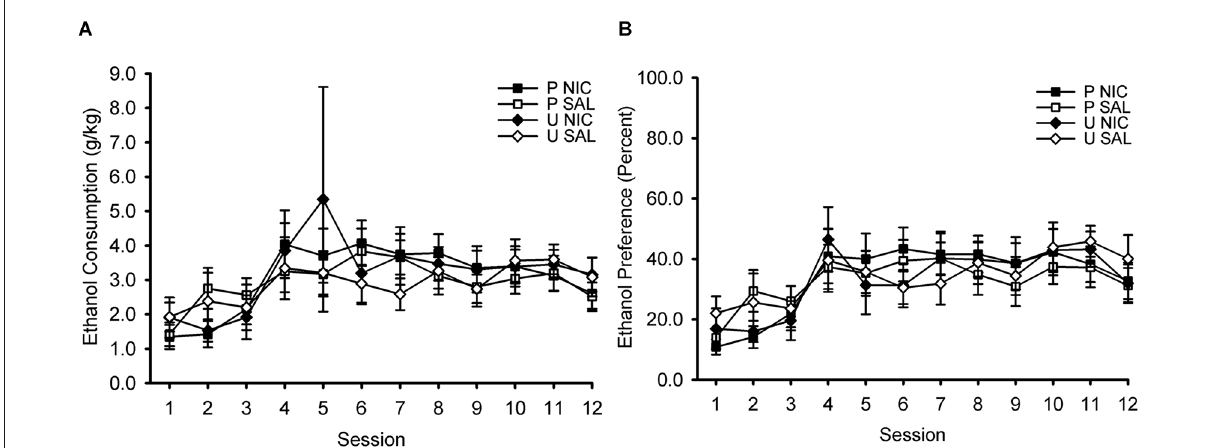
FIGURE2 Ethanol consumption (A) and ethanol preference (B) increased across sessions of intermittent access to 15% ethanol and water in the home cage. Data represent the mean ( ± SEM) values for each session. After this phase, rats were divided into four groups for Pavlovian conditioning training, in which they received either paired (P) or unpaired (U) trials of an audiovisual conditioned stimulus (CS) and ethanol unconditioned stimulus (US) and pre-session injections of either nicotine (NIC) or saline (SAL). This design resulted in the following four groups: P NIC (black squares), P SAL (white squares), U NIC (black diamonds), and U SAL (white diamonds). There were no differences in ethanol consumption or ethanol preference between these four training